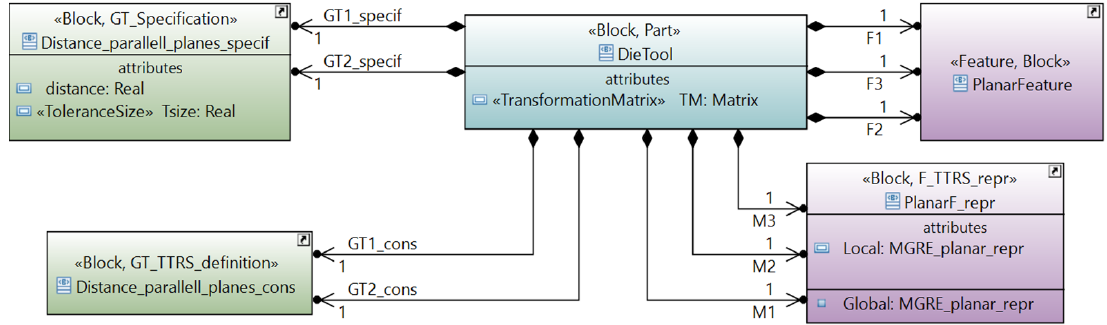
Figure 18. BDD to represent TTRS ‐ based structure of the DieTool Block.